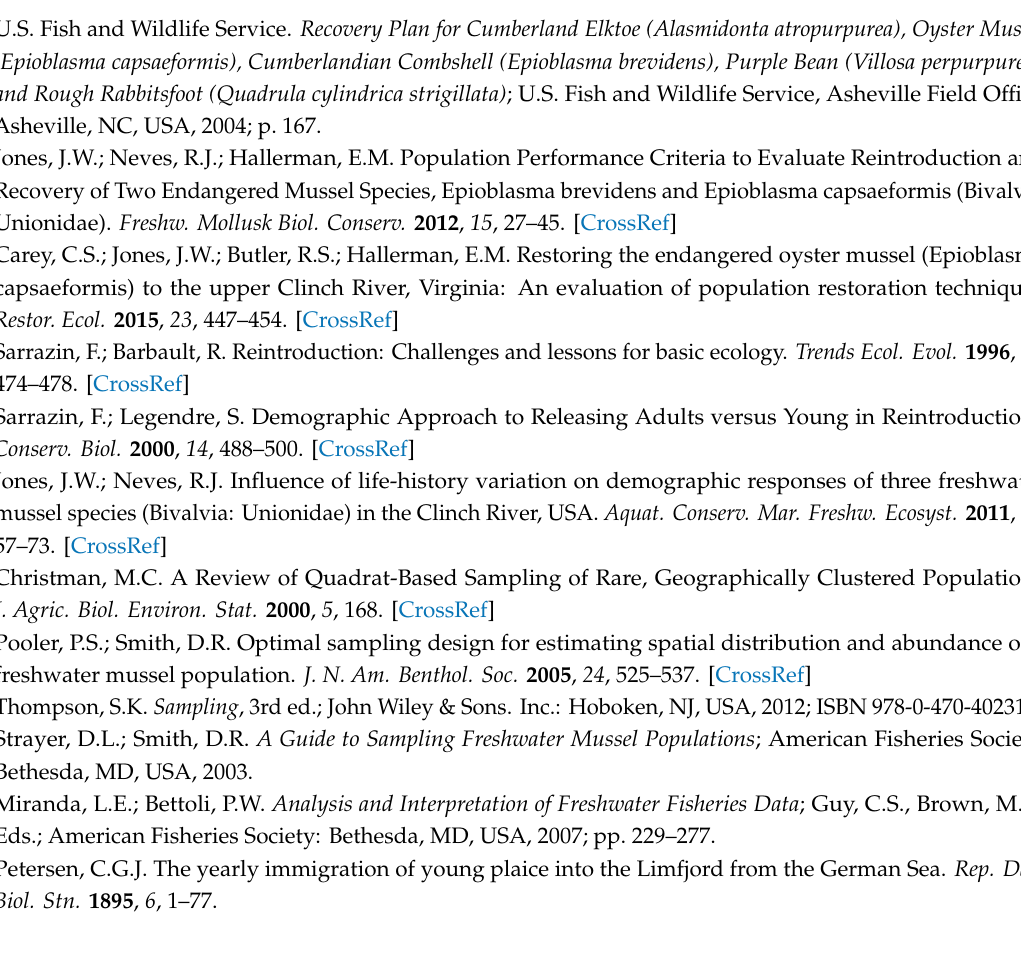
ϕ − ϕ 11 15 ) were fixed at